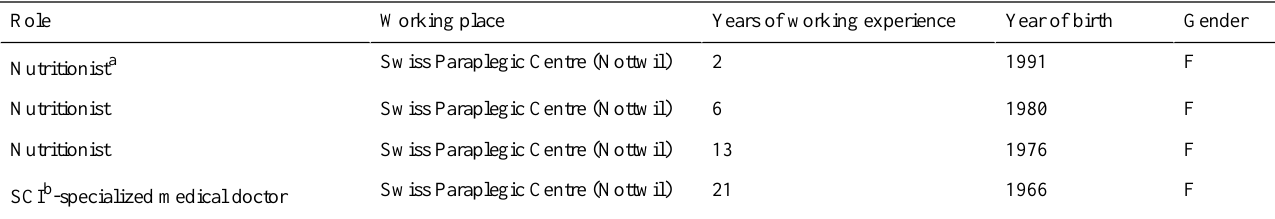
Table 3. Characteristics of the participants consulted for recommendations on